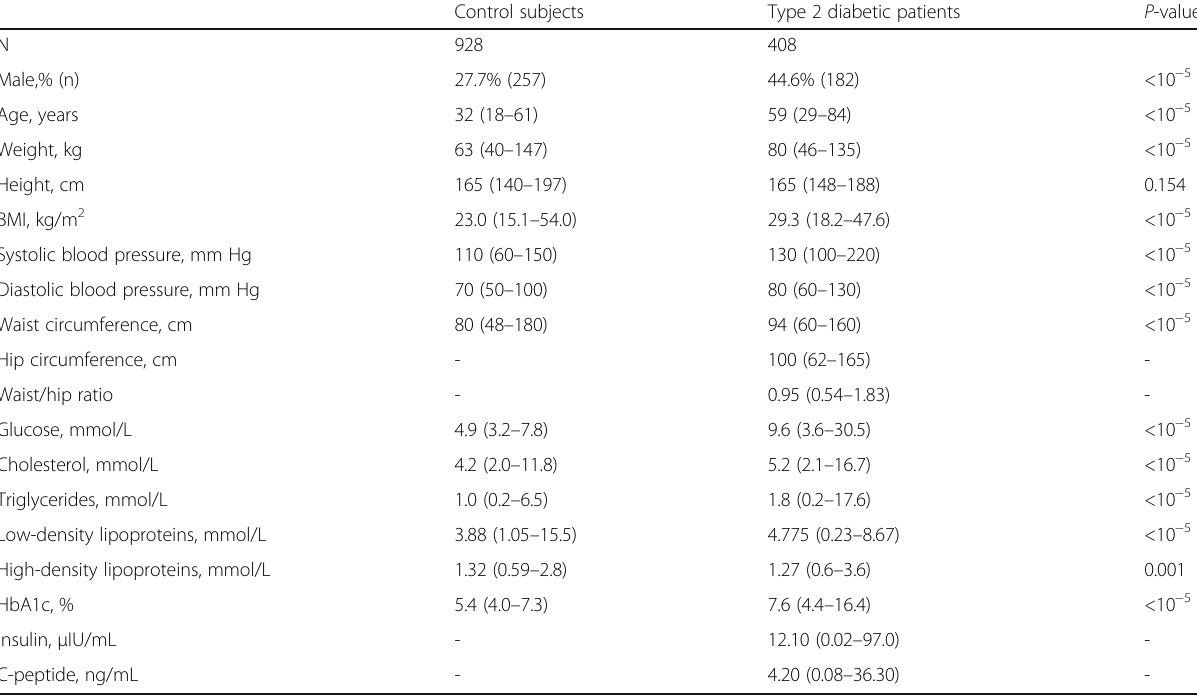
Table 2 Clinical and biochemical characteristics of the general study